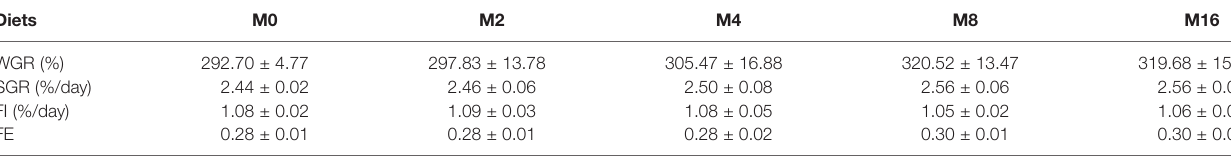
TABLE 2 | Effects of dietary MOS on growth performance of Litopenaeus vannamei